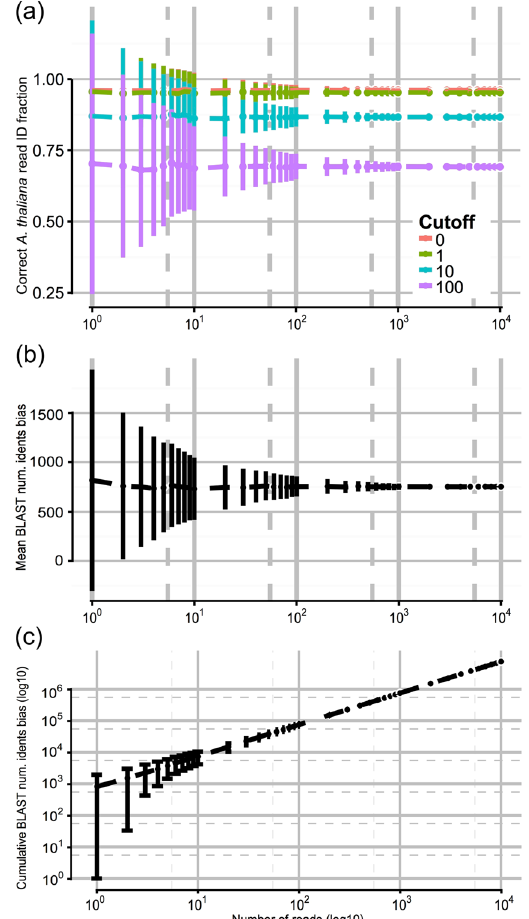
Figure 3. Simulated accumulation curves for rapid species identification by DNA sequencing. 34k pairwise BLASTN hits of A . thaliana RTnS reads were subsampled without replacement to simulate an incremental accumulation of data (10 4 reads; 10 3 replicates). For each read the total identities bias ( ∆ L I ) is the number of identities with the A . thaliana reference minus the number of identities with the A . lyrata reference. ( a) the proportion of A . thaliana reads correctly identified on a per-read basis, classified as A . thaliana where ∆ L I > threshold cutoff (0, 1, 10 or 100). ( b ) Mean ∆ L I in the simulated dataset rapidly stabilises on the population mean ( + 754 bp, e.g. an average matching read alignment to A . thaliana is 754 bp longer than to A